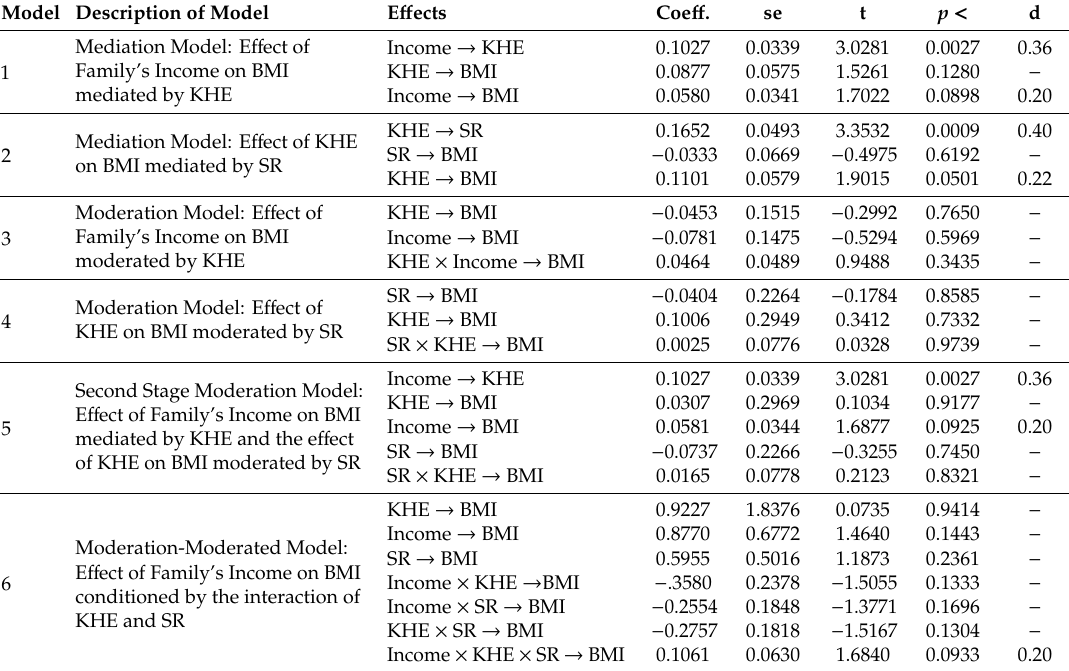
Table 3. Results of the Mediation, Moderation, and Conditional Process